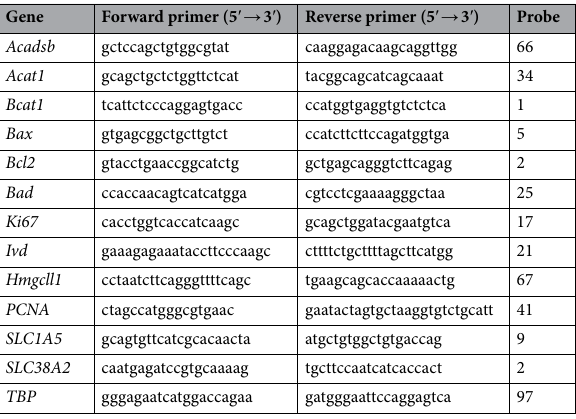
Table 3. List of qPCR primers used, along with their respective probes from the universal probe library.